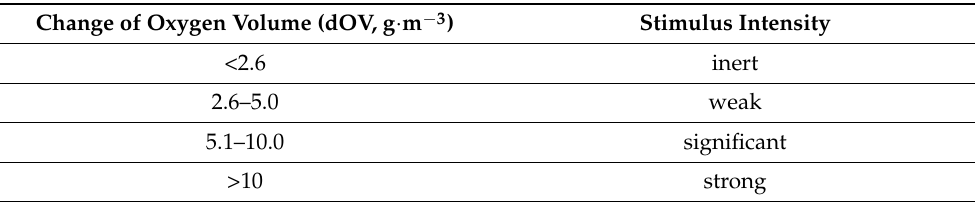
Table 3. Inter-day change of oxygen volume in the air and the intensity of the biothermal stimulus